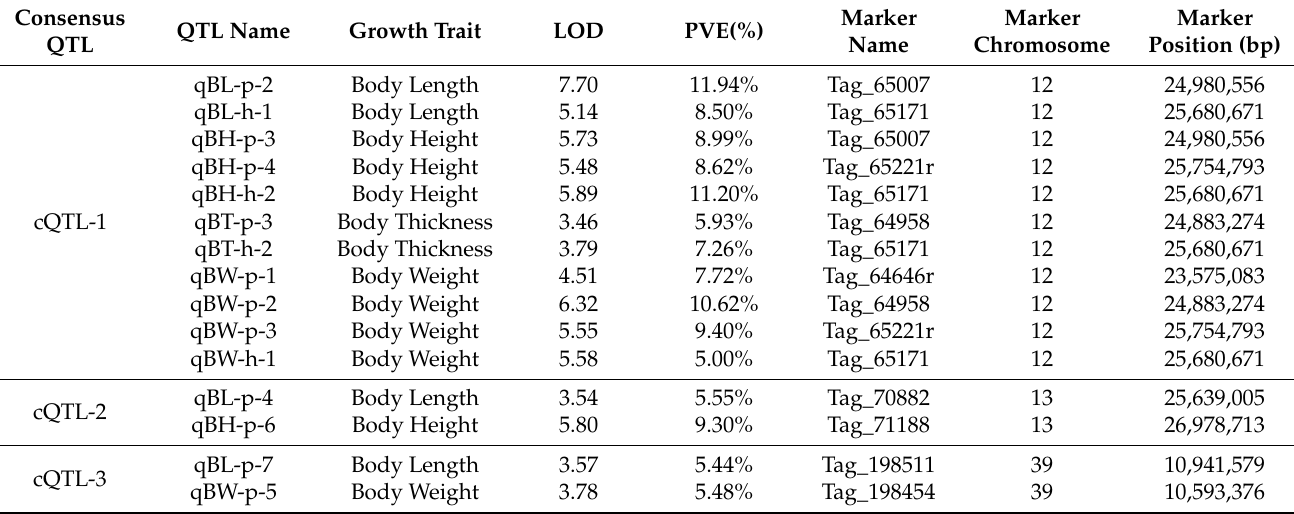
Table 6. Consensus QTL identified in Yellow River carp 5–17 months after hatching.